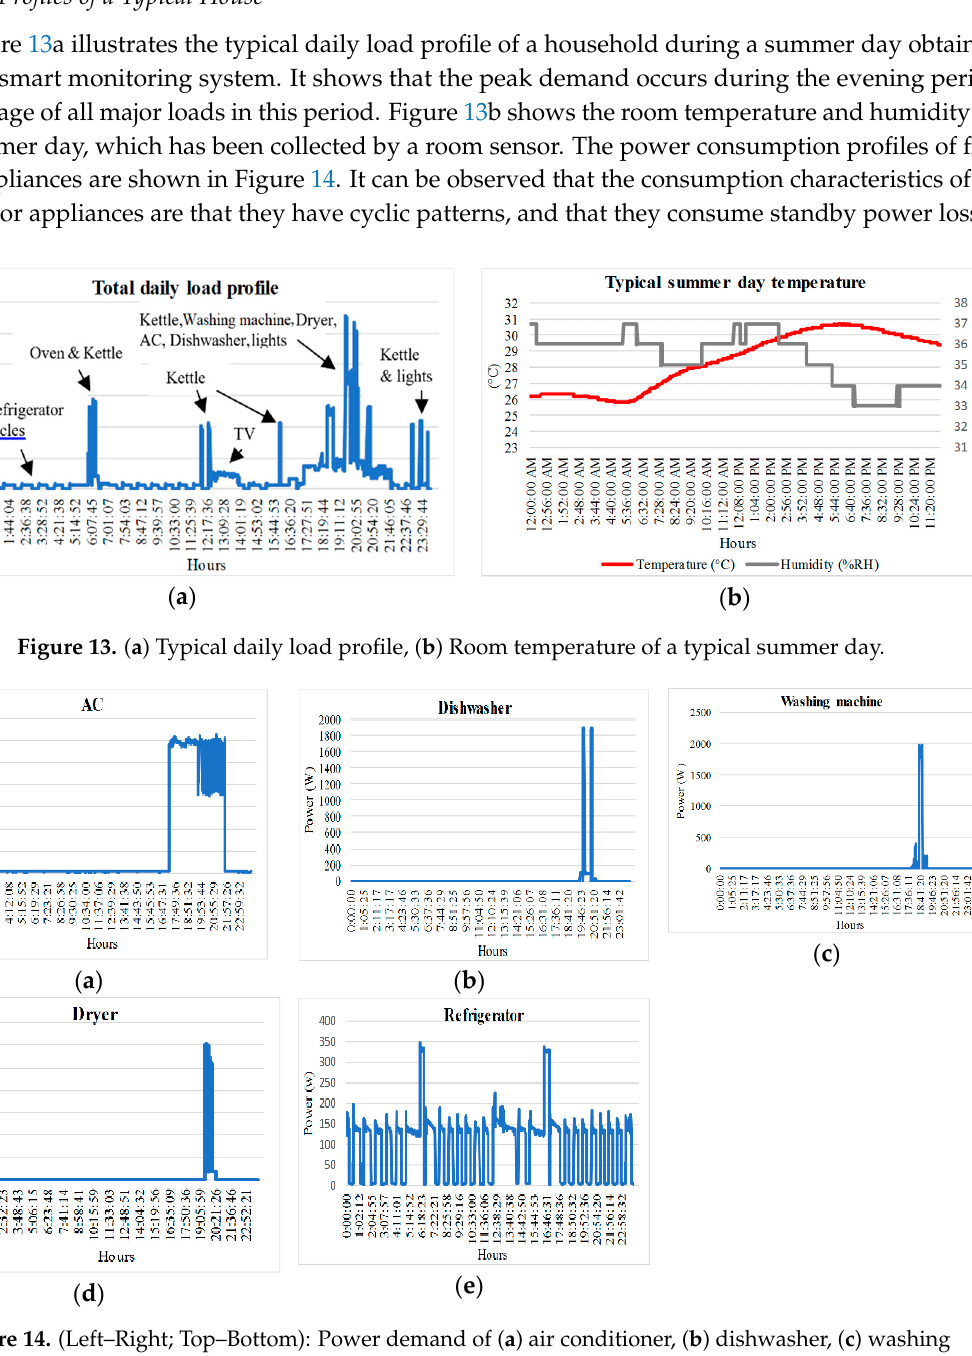
Figure 14. (Left–Right; Top–Bottom): Power demand of ( a ) air conditioner, ( b ) dishwasher, ( c ) washing machine, ( d ) dryer, and ( e ) refrigerator.